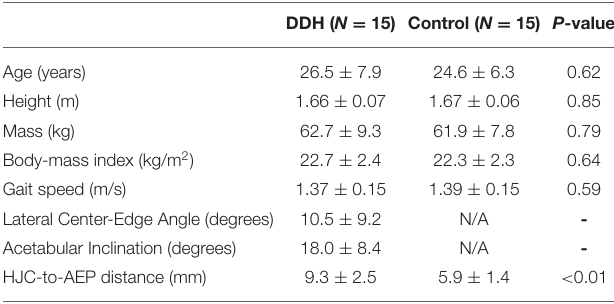
TABLE 1 | Demographics, gait speed, radiographic measures, and the HJC-to-AEP distance (mean ± SD) of DDH and control